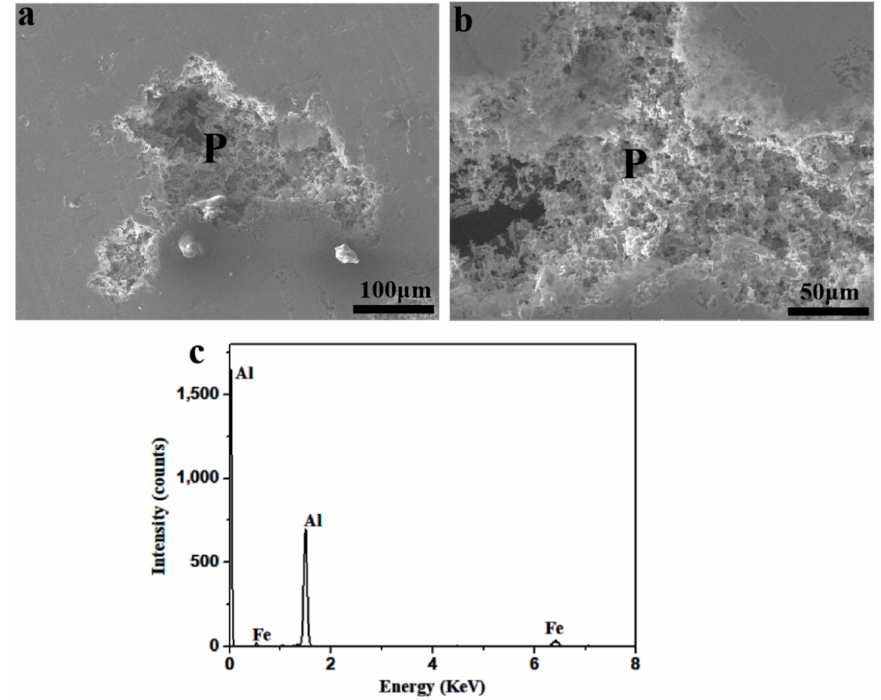
Figure 6. EDS analysis of the corrosion pit P. ( a , b ) SEM images of corrosion pits; ( c ) EDS